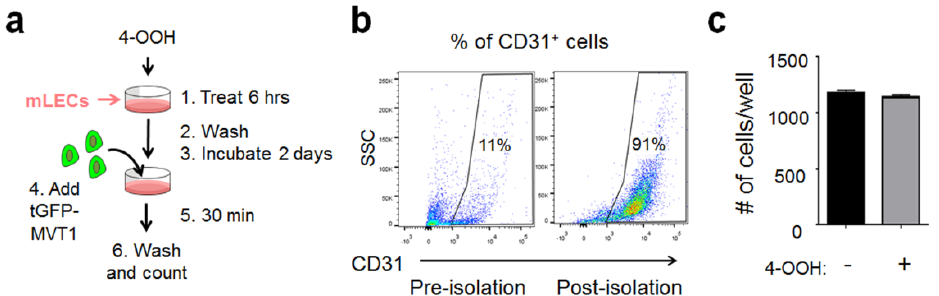
Figure 2. Active CTX was unable to modify the mLECs to allow more cancer cell adhesion in vitro. ( a ) A schematic of the in vitro cancer cell-mLEC adhesion assay. ( b ) Shown is a representative mLEC purity determined by CD31 positivity via flow cytometry. ( c ) Quantification of tGFP-MVT1 cells per well (in 96-well plates) adhered to mLECs pre-treated with 4-hydroperoxy-cyclophosphamide (4-OOH) (+) or vehicle (−) ( n = 6 from 2 independent experiments). Bars indicate mean ± SEM; Student’s t test.